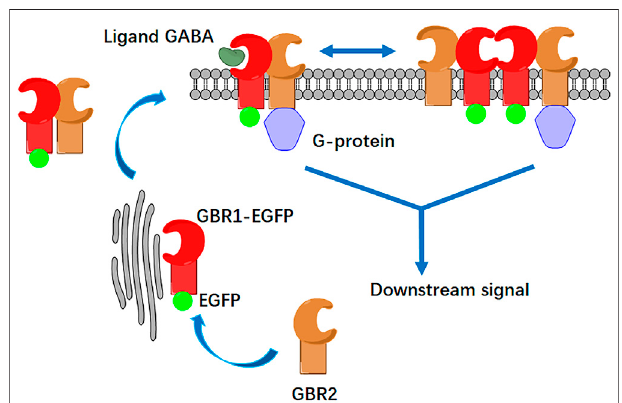
FIGURE 1 | Schematic illustration of GABAB receptor activation and its aggregationatcellmembrane.TheGABABreceptorconsistsoftwosubunits: GBR1 and GBR2. GBR1 carries the endoplasmic reticulum (ER) retention signal (RSRR); thus, it is retained in the endoplasmic reticulum. When GBR1 binds with GBR2 to form a heterodimer, GBR2 blocks the RRSR of GBR1,andbothofthemcoulddocktothemembrane.Onthecellmembrane, the heterodimer can also be associated to form a tetramer. After GABA ligand stimulation, heterodimers and tetramers bind to Gi/o proteins to activate the downstream signaling pathway. Either receptor dimer or tetramer only binds with 1 G